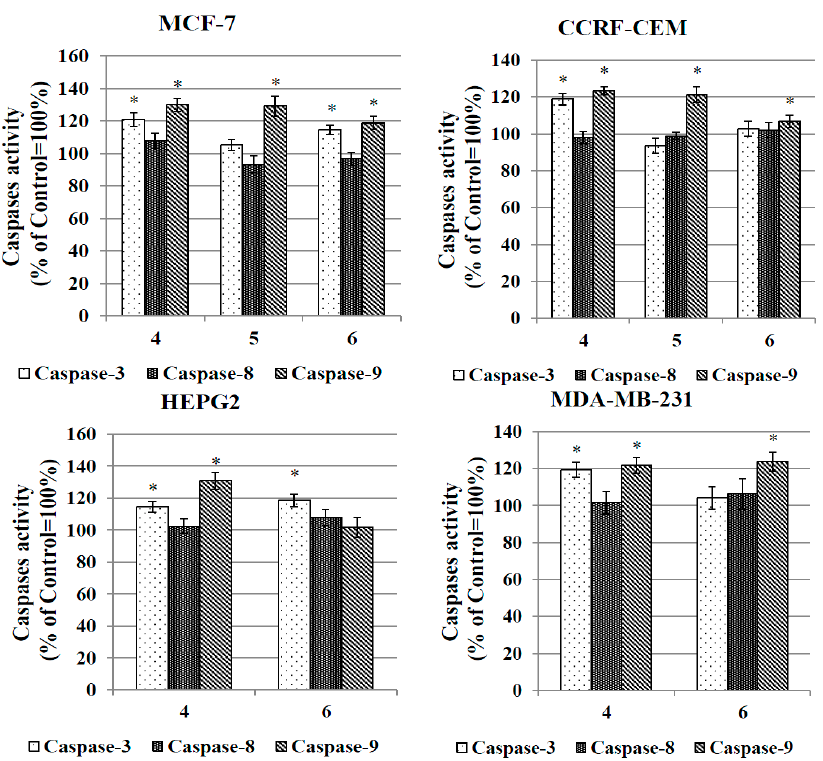
Figure 9. Relative activity of caspase-3, caspase-8 and capase-9 in human cancer cells treated with the IC 50 concentrations of complexes 4 , 5 and 6 for 24 h. The results represent the mean ± SEM of the data from 3 to 4 individual experiments, each done at least in triplicate. * p < 0.05 vs. control.